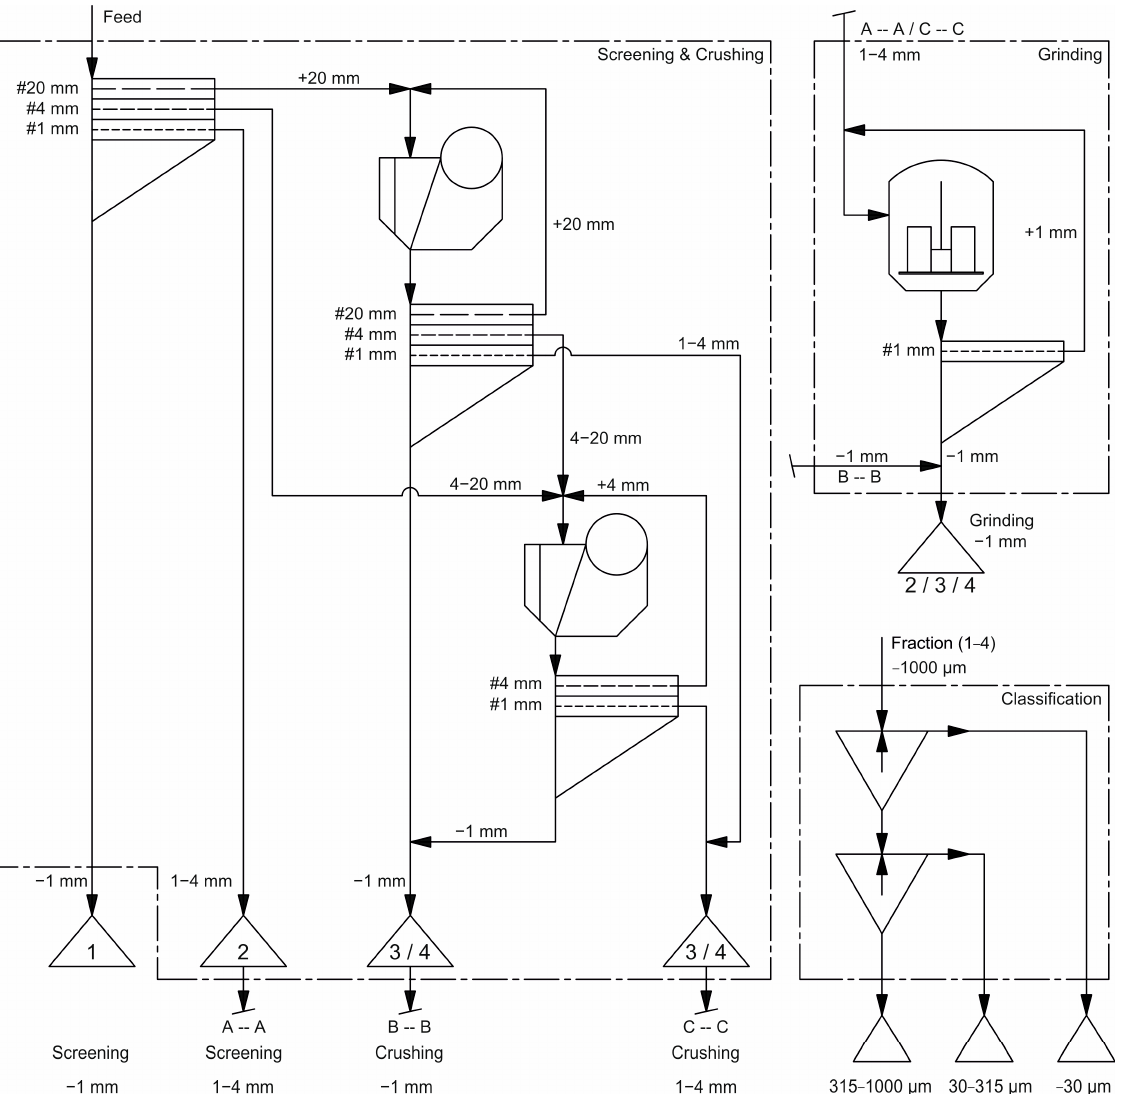
Figure 5. Flowchart of comminution and classification steps. Fractions 1, 2, and 3 resulted from